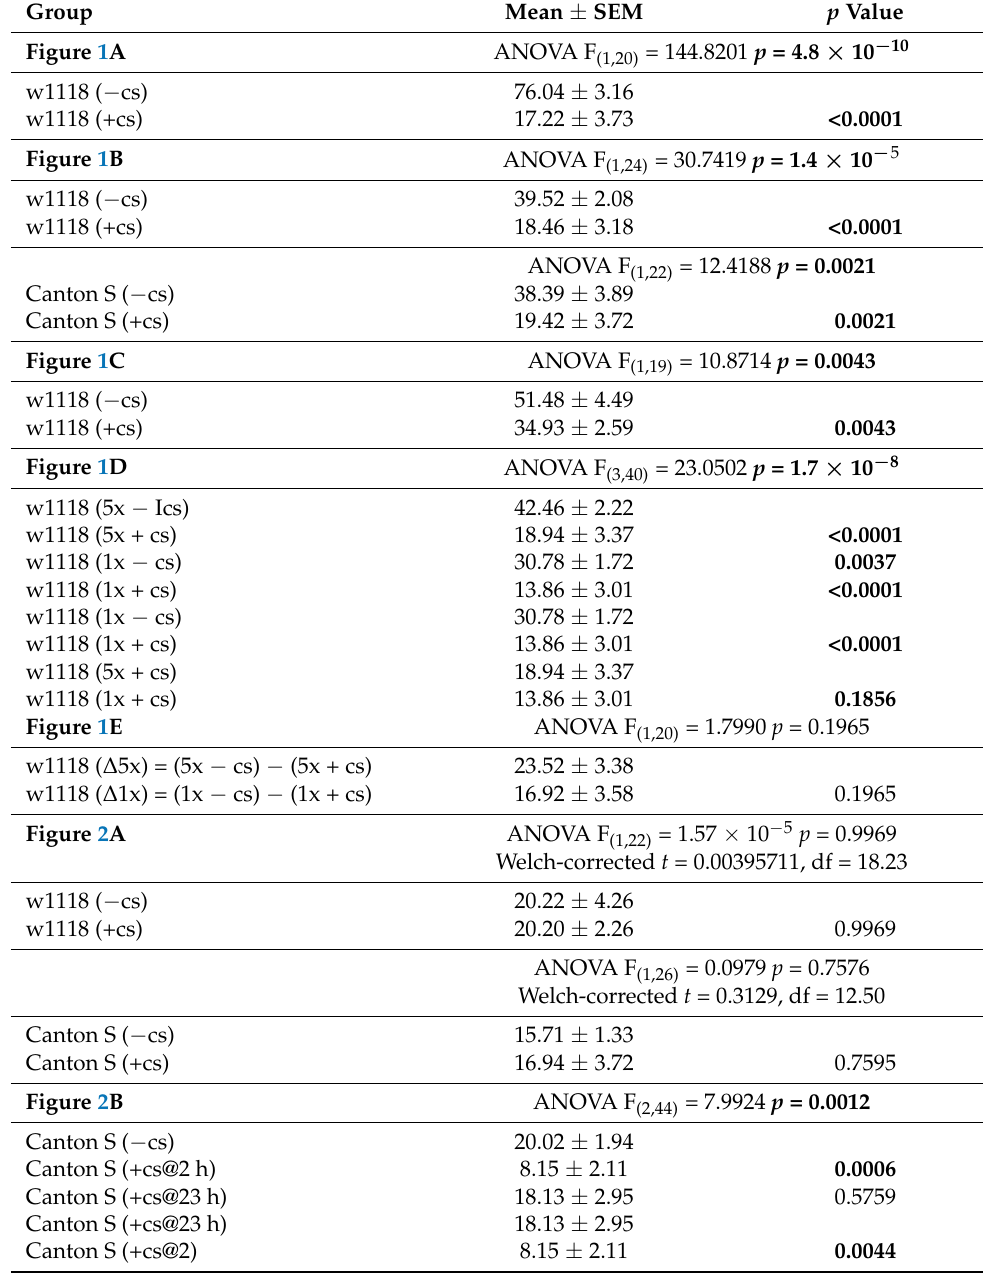
Table 1. Statistical comparisons. Note the final two comparisons in analysis regarding Figures 1D and 2B are not with the relevant control, but rather between treatments. Bold numbers indicated significant p